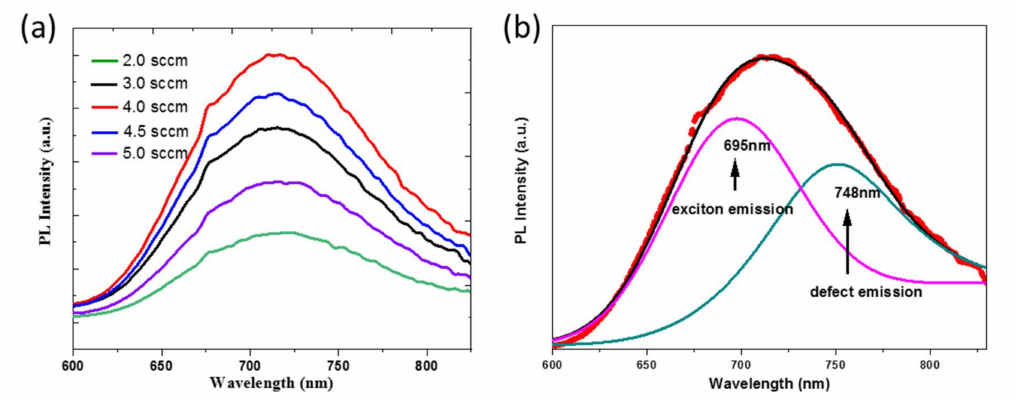
Figure 5. ( a ) The PL spectra of the Nb:SnO 2 thin films as a function of O 2 flow rate. ( b ) PL spectra of the thin films after fitting at the O 2 flow rate of 4.0 sccm. All the spectra are excited by the 300 nm line of a xenon